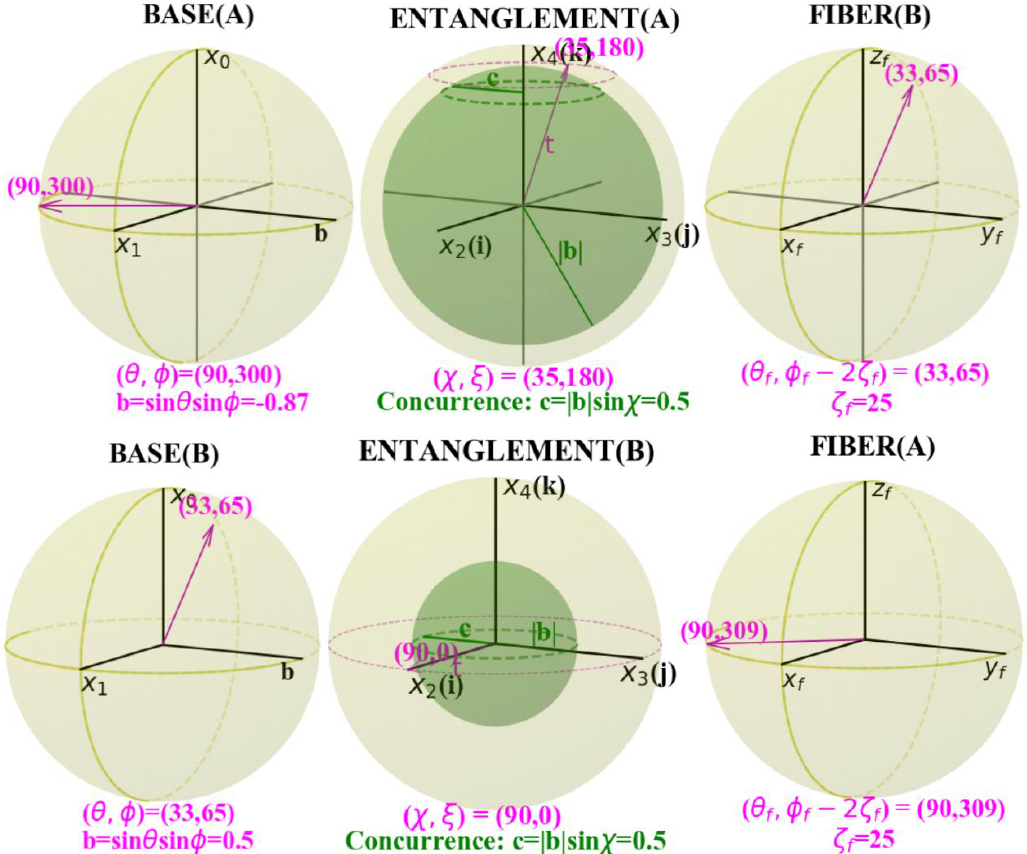
Figure 7. The two sets of Bloch spheres after the partial entanglement and a local rotation induced by R x (60 ◦ ) ⊗ I → C-R y (70 ◦ ) → R y (90 ◦ ) ⊗ I in the circuit of Figure 5, where the rotation angles are η = 60 ◦ , ω = 70 ◦ , µ = 90 ◦ , and ν = 0 ◦ . For the top row, qubit-A is the base qubit, and for the bottom row, qubit-B is the base qubit. After Figure 6, R y (90 ◦ ) is applied to qubit-A.